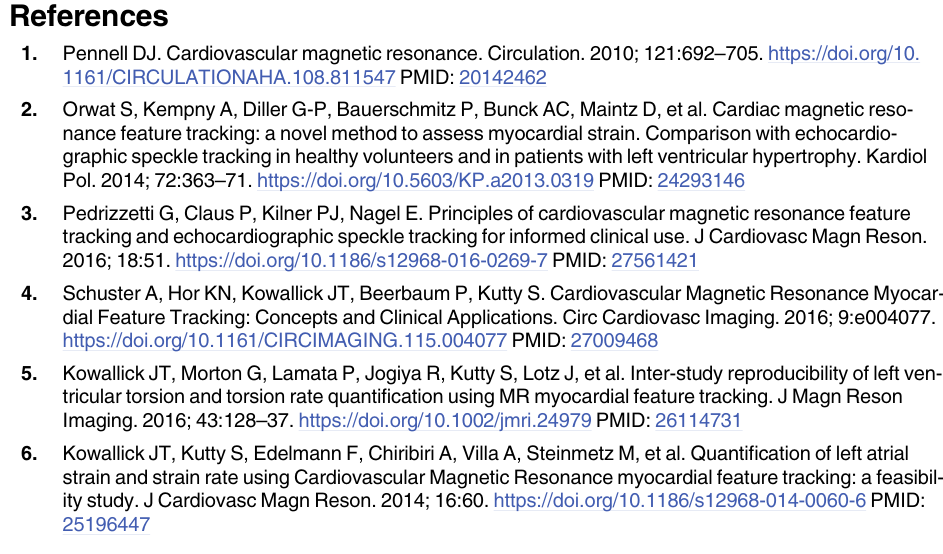
right ventricle, GLS: global longitudinal strain, GCS: global circumferential strain, GRS: global radial strain, Δ :